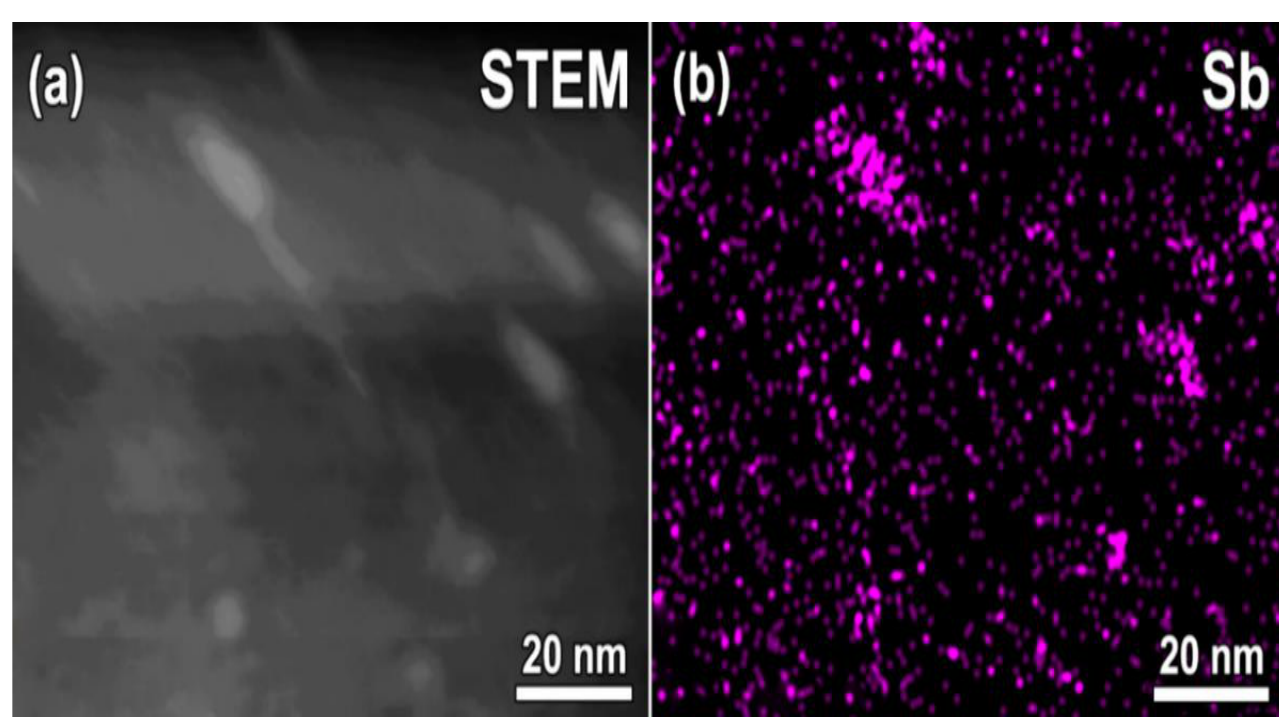
Figure 4. LT-Al 0.6 Ga 0.4 As 0.97 Sb 0.03 layer annealed at 600 °C: ( a ) Transmission electron micrograph in the STEM-HAADF mode; ( b ) Sb distribution map of the same area collected by EDXS.